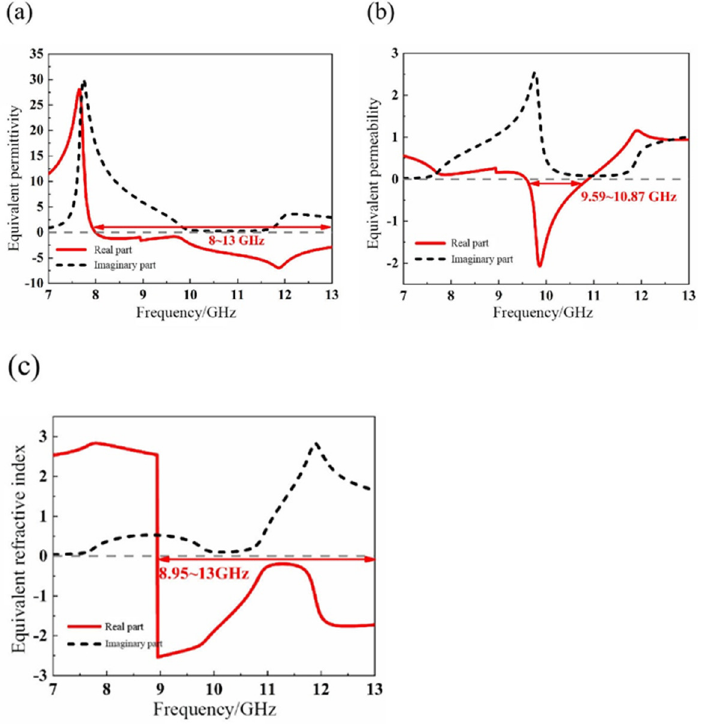
Figure 8. Graph of equivalent electromagnetic parameters ( a ) Equivalent permittivity ε ; ( b ) Equivalent permeability μ ; ( c ) Equivalent refractive index n.